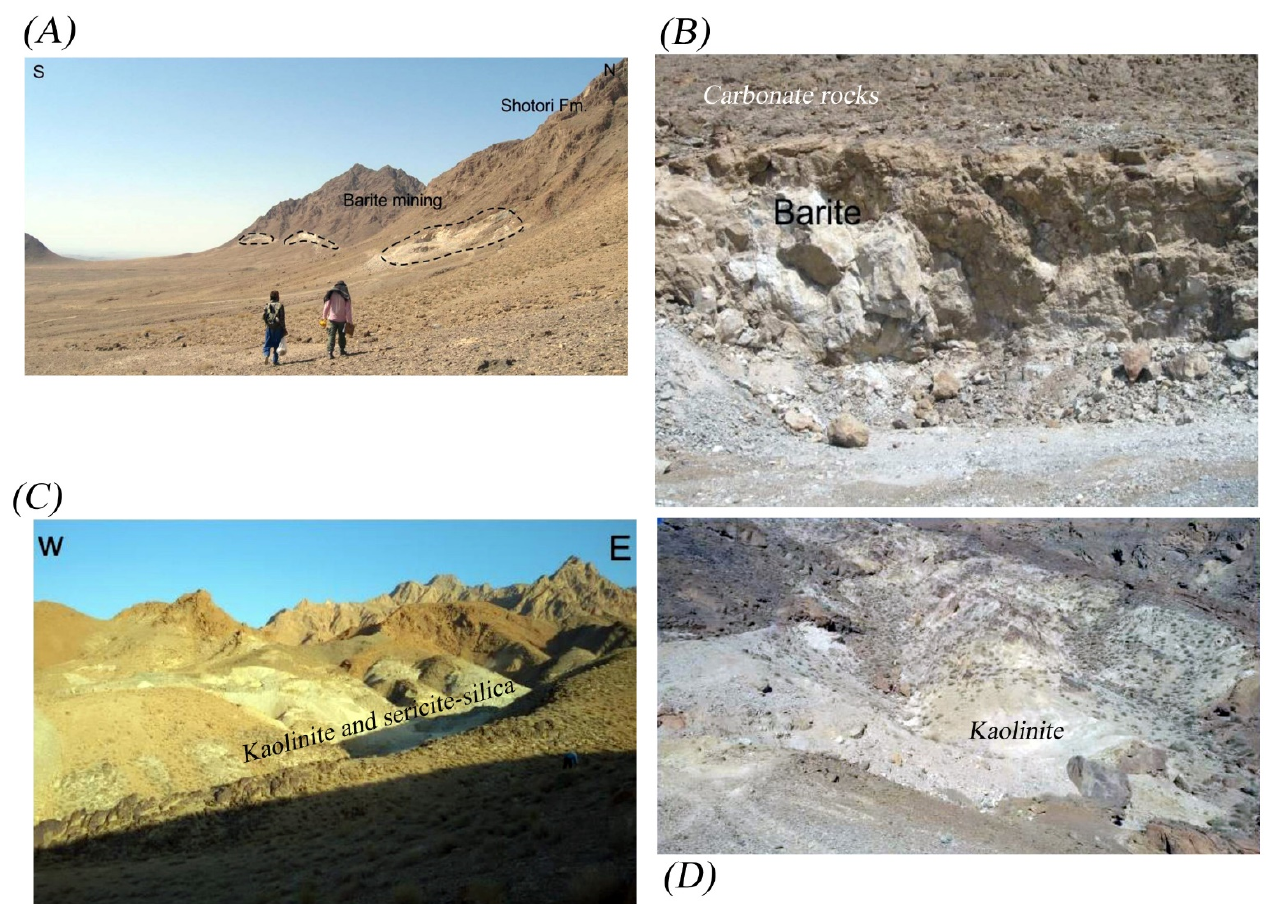
Figure 13. Field photographs of alteration and mineralization in the study area. ( A ) Lenticular bodies of barite hosted in the Paleozoic sedimentary rocks; ( B ) Barite veins filled along the main fractures and faults in carbonate rocks; ( C ) Surface expression of the argillic alteration zone as (kaolinite) and sericite-silica; ( D ) Argillic alteration zone as surface expression of kaolinite. A confusion matrix (error matrix) and kappa coefficient [46–48] were calculated for the mineral potential maps versus field data. The comparison of the mineral potential